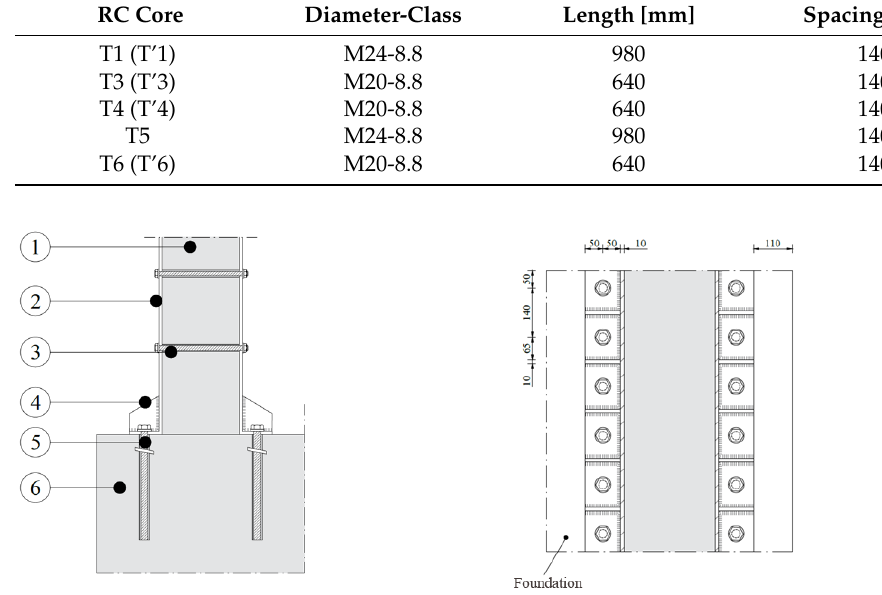
Figure 16. Construction detail of the connection to the foundation. ( 1 ) Existing RC wall; ( 2 ) Steel plates; ( 3 ) M16 bolts; ( 4 ) Stiffening plate with height of 120 mm; ( 5 ) Anchor bolts (M20 or